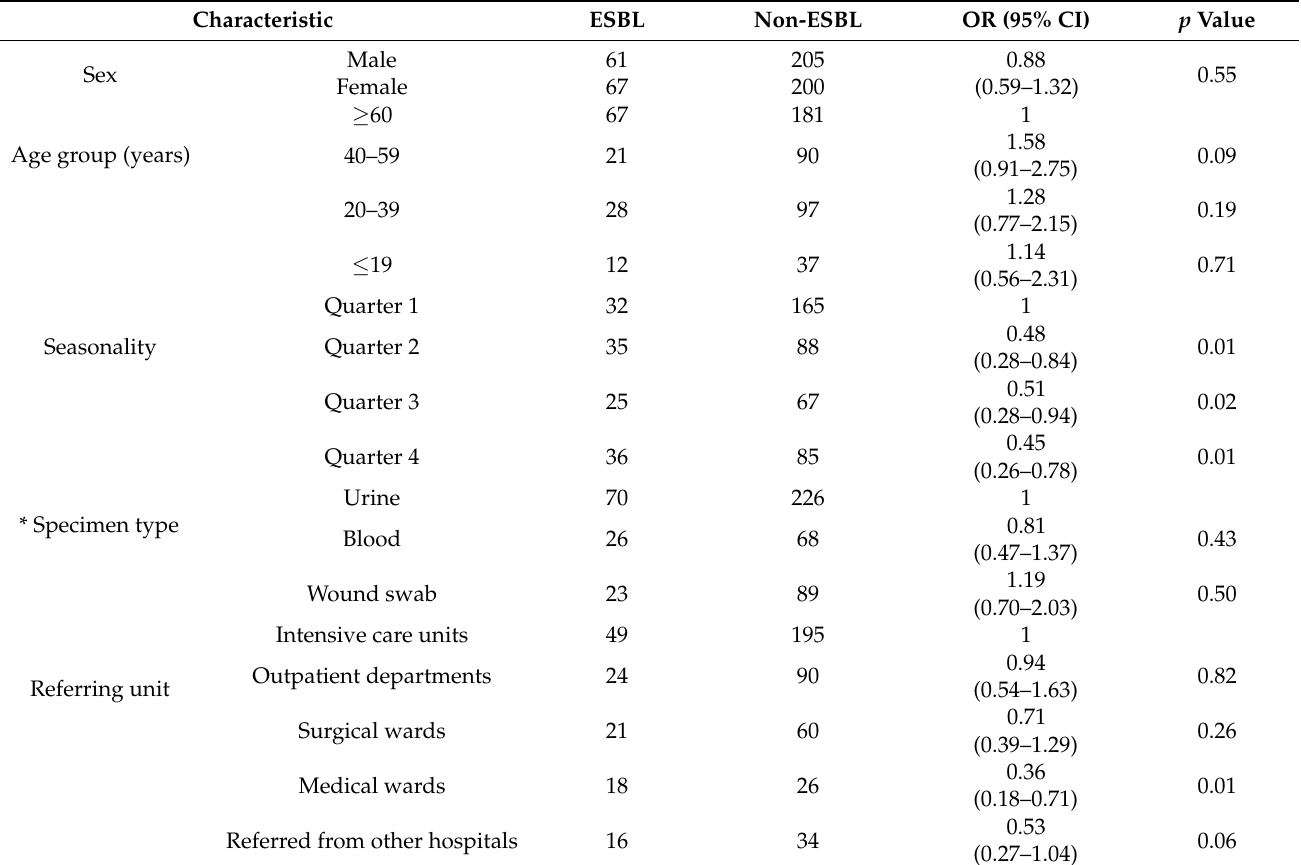
Table 3. Sociodemographic distribution characteristics of ESBL isolates ( n =